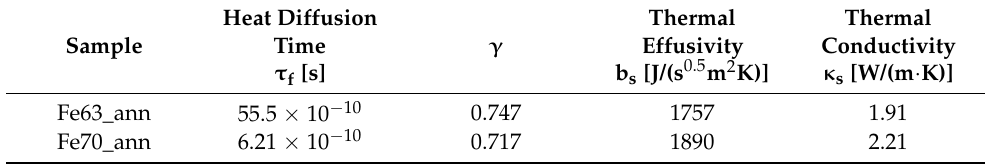
Table A1. Thermal properties of samples Fe63_ann and